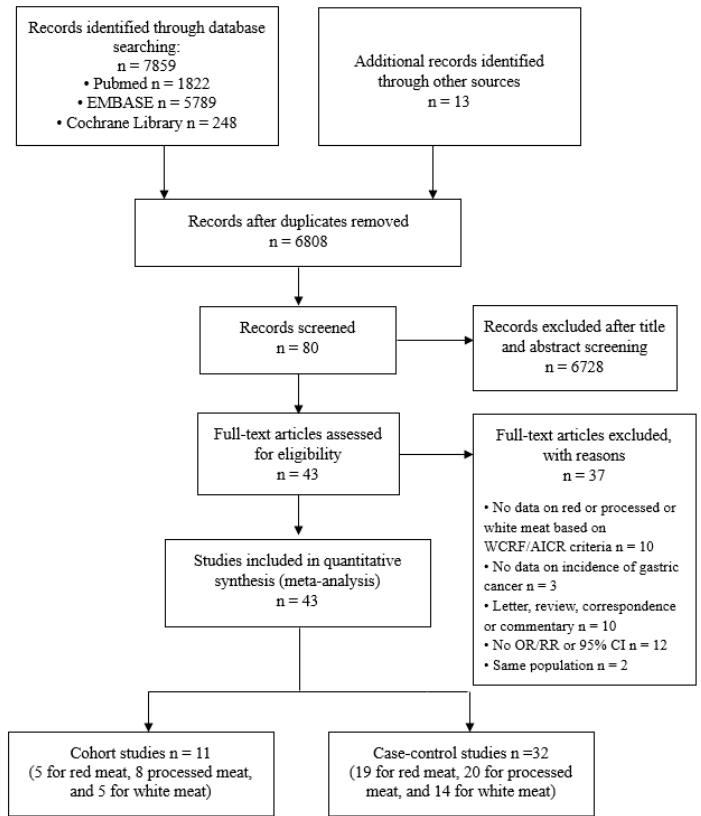
Figure 1. Flow diagram for the selection of studies. A total of 43 studies for quantitative meta-analysis were selected using the Preferred Reporting Items for Systematic Reviews and Meta-analyses (PRISMA) 2009 flow diagram.